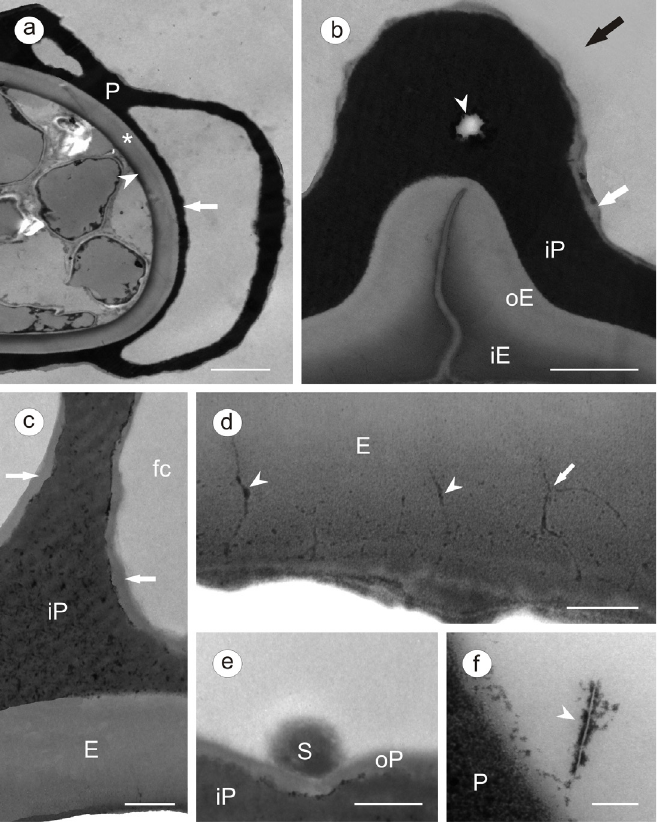
Figure 5. Spores of Dryopteris wallichiana with TEM. a. The folded perispore is observed. The arrowhead shows the base of the fold. The asterisk shows outer exospore and the arrow shows inner exospore. P: perispore. b. The laesura is seen in section. The outer exospore (oE) is less contrasted than the inner exospore (iE). The inner perispore (iP) is more contrasted than the outer perispore (black arrow). A supralaesural fold (white arrow) with fold cavity (arrowhead) is observed. c. Section through the sporoderm. The outer perispore (arrows) covers the inner perispore (iP) both outside the fold as fold cavity (fc). E: exospore. d. Simple (arrowheads) and branched (arrow) channels is observed in the inner exospore (E). e. A spheroid (S) is seen in the perispore surface. It has contrast and structure as the perispore. iP: inner perispore. oP: outer perispore. f. A scale (arrowhead) is seen on the perispore. P: perispore. Scale bars: a = 3 µm; b, e = 1 µm; c, d, f = 0.2